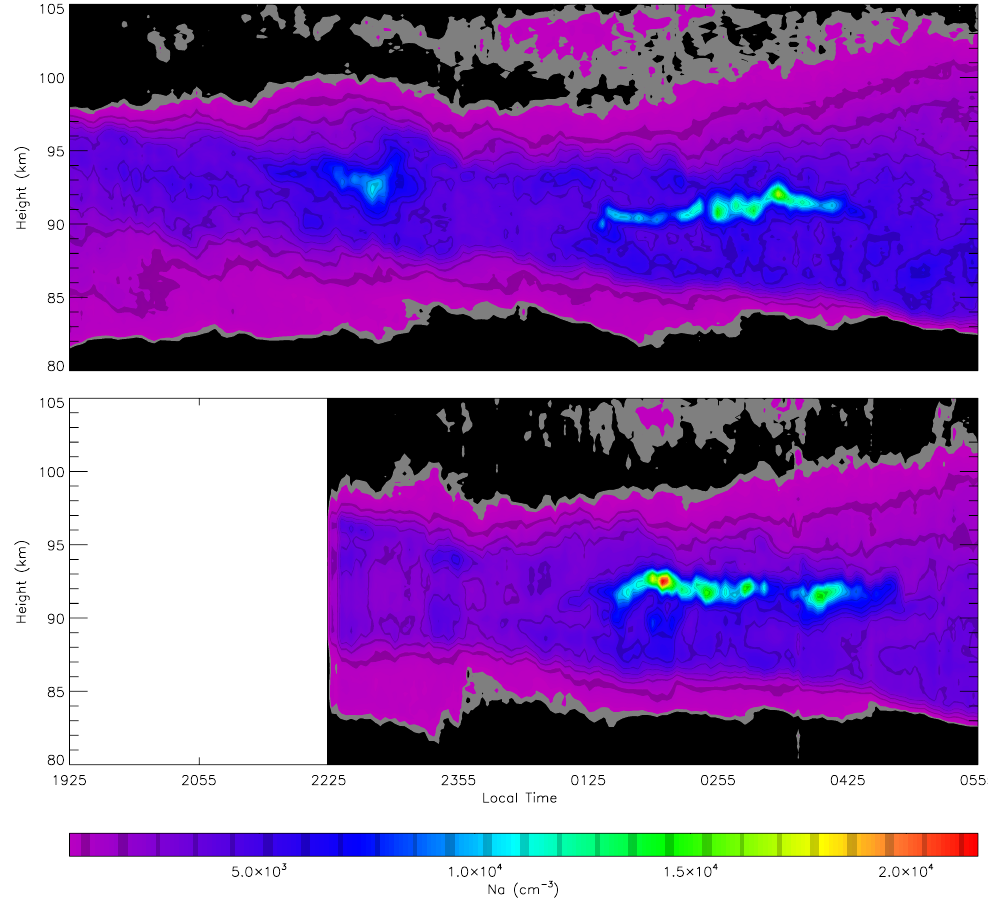
Fig. 6. Co-observation of USTC lidar (upper panel) and WIPM lidar (bottom panel) for an SSL event on 2 November 2007 at Hefei and Wuhan.